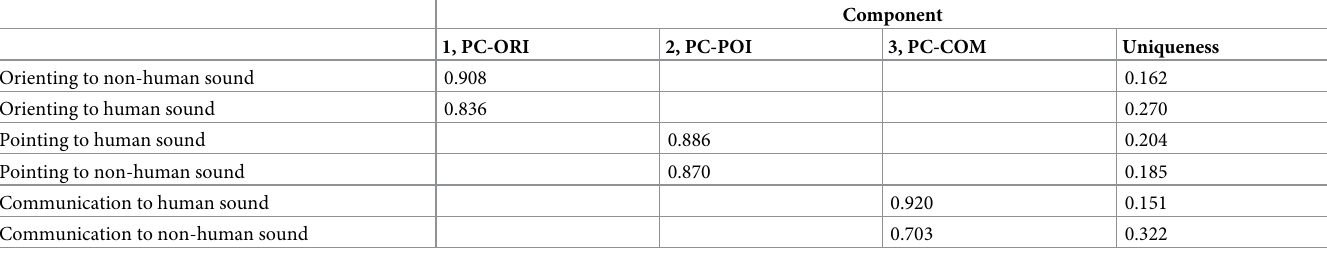
Table 1. Non-constrained Varimax solution for socio-cognitive behaviors principal component analysis (N =